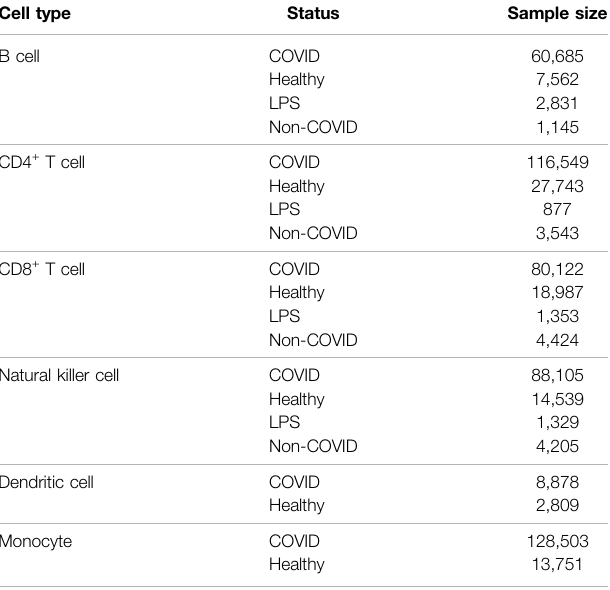
TABLE 1 | Sample sizes of various disease statuses on different cell